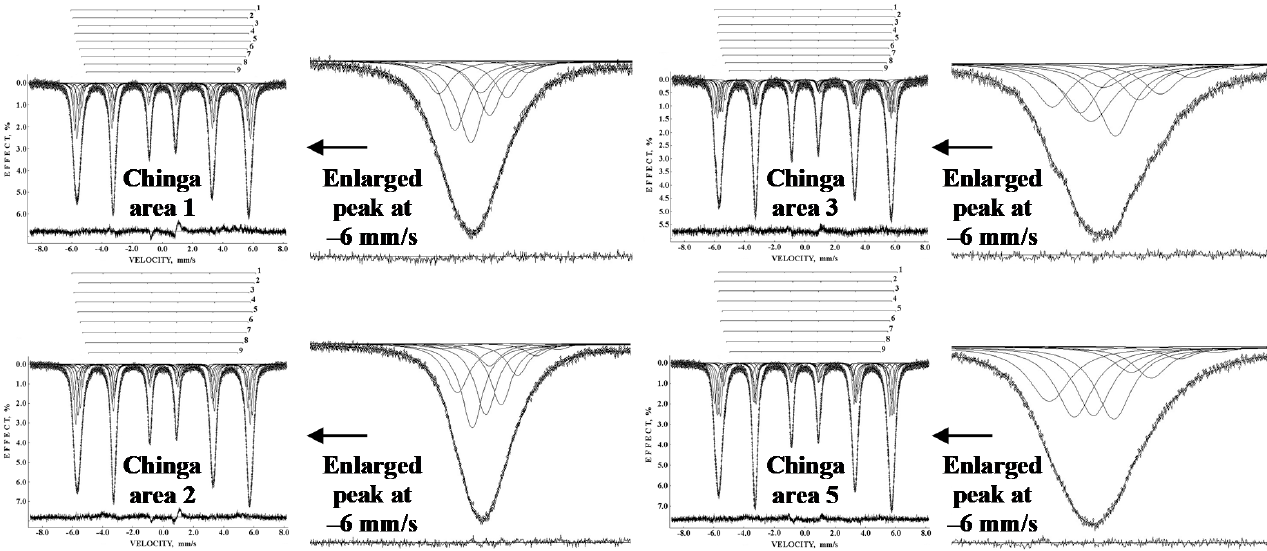
Figure 31. Comparison of the room temperature Mössbauer spectra of different powdered samples of the Chinga iron-ung meteorite obtained from areas 1 , 2 , 3 , and 5 ; the most negative peaks of these spectra are enlarged. The differential spectra are shown on the bottom. Adapted from [80].